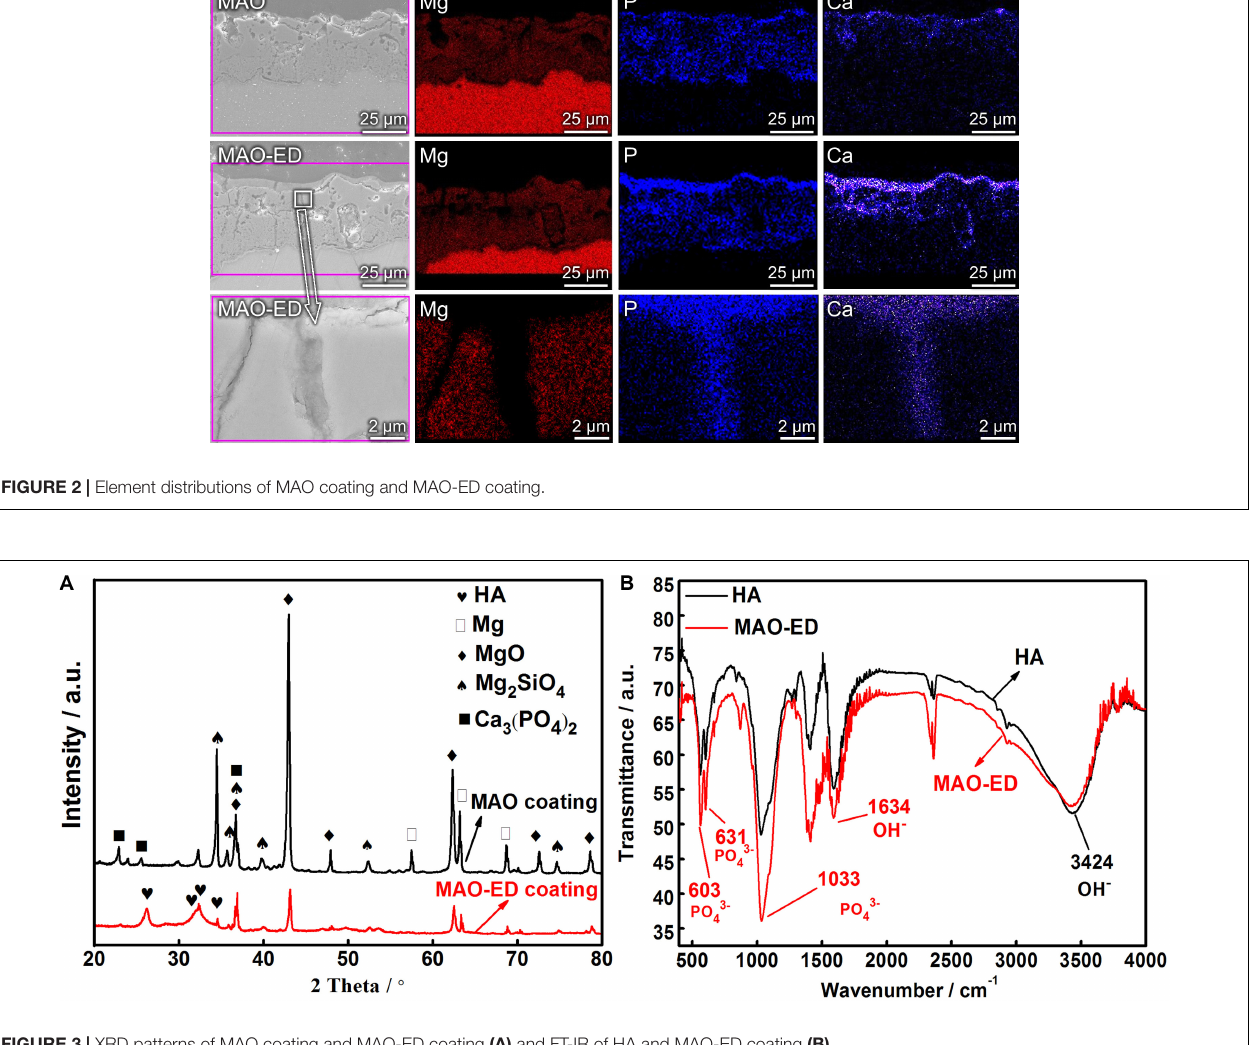
FIGURE 3 | XRD patterns of MAO coating and MAO-ED coating (A) and FT-IR of HA and MAO-ED coating (B) .